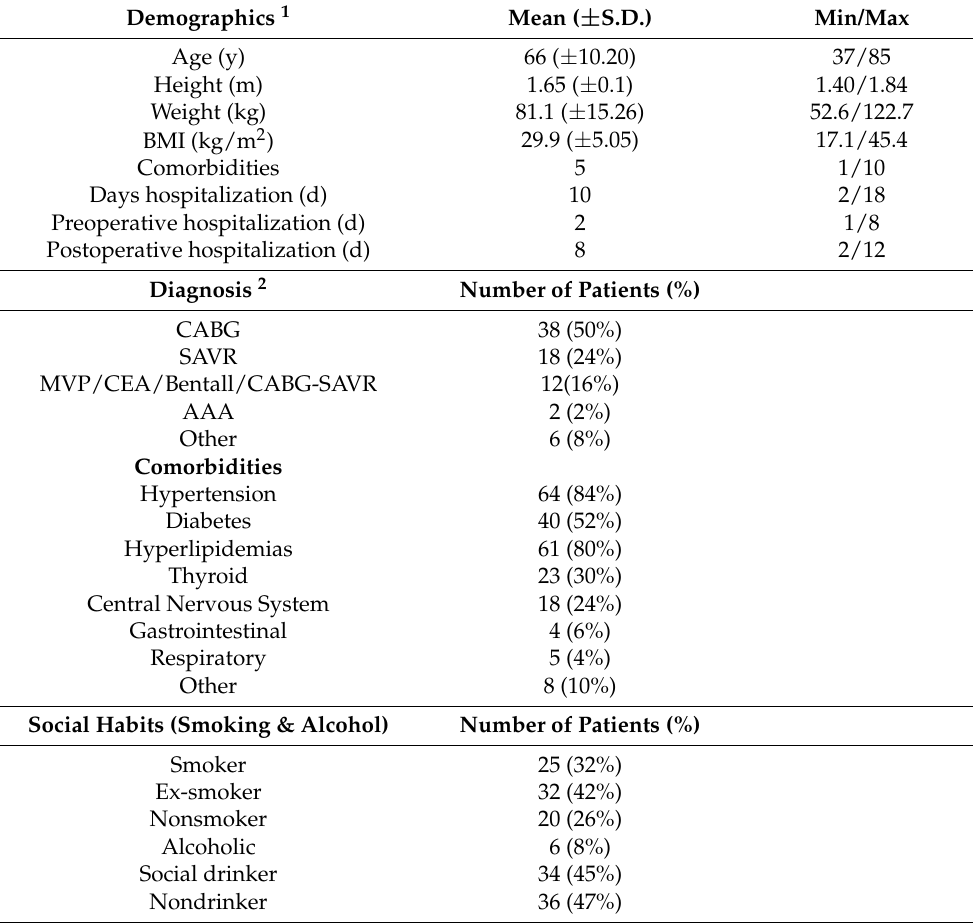
Table 2. Demographic characteristics, diagnosis, and comorbidities for CVD patients of the